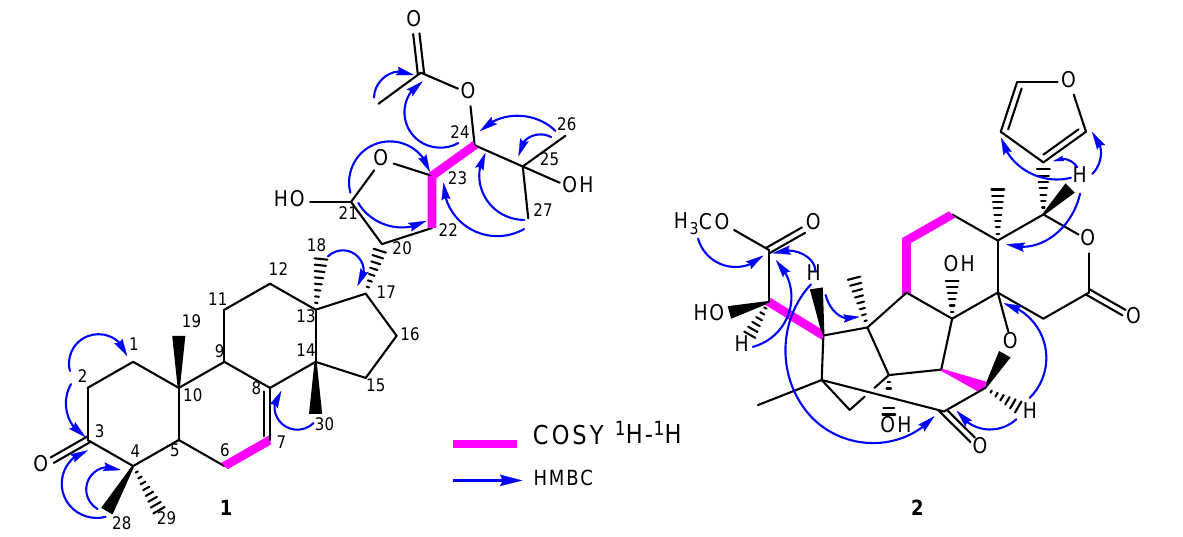
= 12.5 Hz, H-29b) in the basic limonoid skeleton, supported the notion that 2 was a phragmalin-type limonoid [40,41].